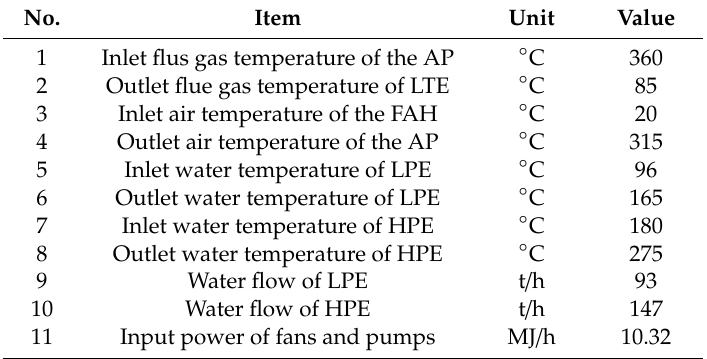
Table 2. Calculation parameters of the coupled high-low energy grade flus gas waste heat recovery systems